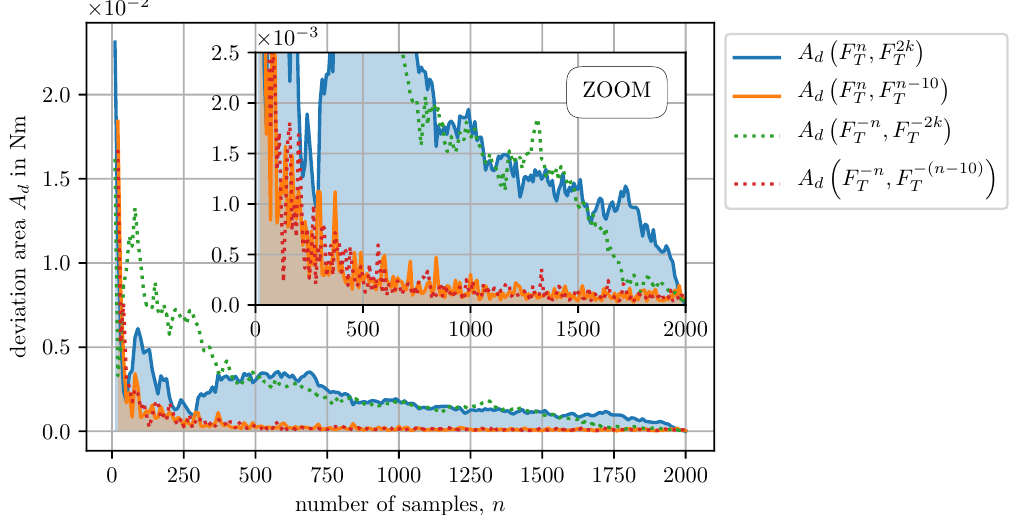
Figure 6. Evolution of A d when F n Dotted lines show the same evaluations, but with the samples used in reversed order, designated by a negative sample index. Inset shows a zoom of the main